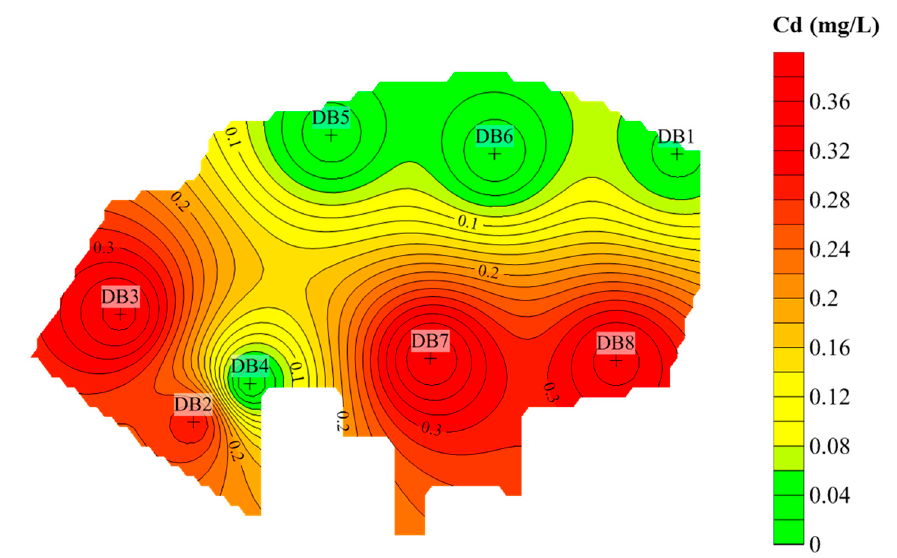
Figure 5. Distribution of Cd pollution concentration in the groundwater in the study area.